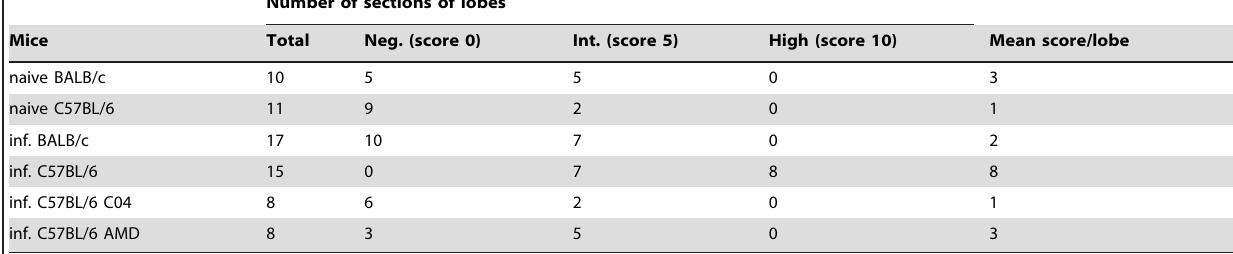
Table 1. CXCL12 intensity score in mesothelial